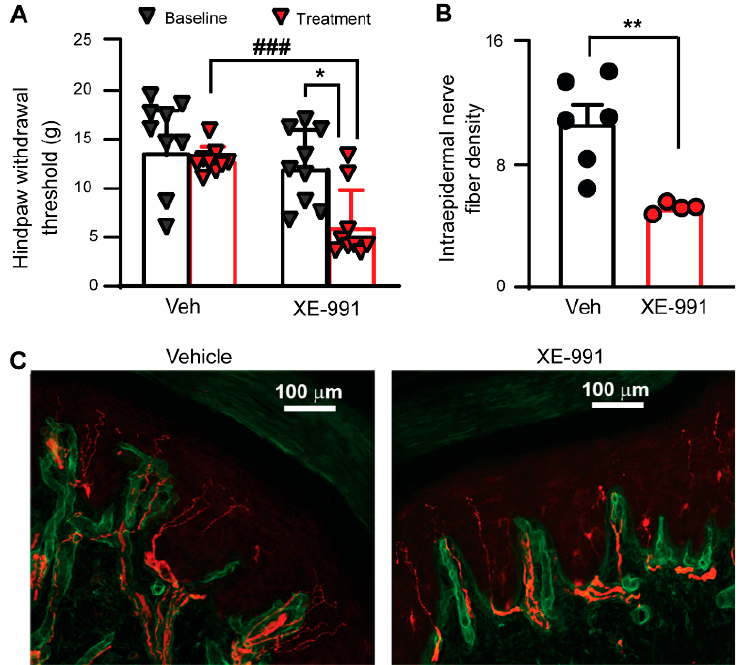
Figure 5. The effect of brief application of XE-991 (1 mg/kg, twice daily for 10 consecutive days) on the degeneration of IENFs and the development of chronic behavioral hypersensitivity. ( A ) Effects of XE-991 on the development of mechanical hypersensitivity in the hind paws (tested 3 weeks after the last XE-991 application). p = 0.5531, t(8) = 0.6191 for the vehicle group; p = 0.0107, t(8) = 3.309 for the XE-991 group, two-tailed paired Student’s t test. p < 0.0001, t(16) = 5.171 for postvehicle vs. postpaclitaxel, two-tailed unpaired Student’s t test. Colored symbols in columns represent one rat each. ( B ) The effect of XE-991 on skin IENF loss. Four to five sections from each rat were counted and averaged. Filled symbols in the bar graph represent individual rats. Unpaired t test (two-tailed). ( C ) Images showing rat skin IENFs (labeled with PGP9.5, red) that crossed the basal lamina (labeled with collagen IV, green) after XE-991 and vehicle treatment. Scale bars, 100 µ m. Data are represented as mean ± SEM. *, p < 0.05; **, p < 0.01; ###, p < 0.001. Veh, vehicle.